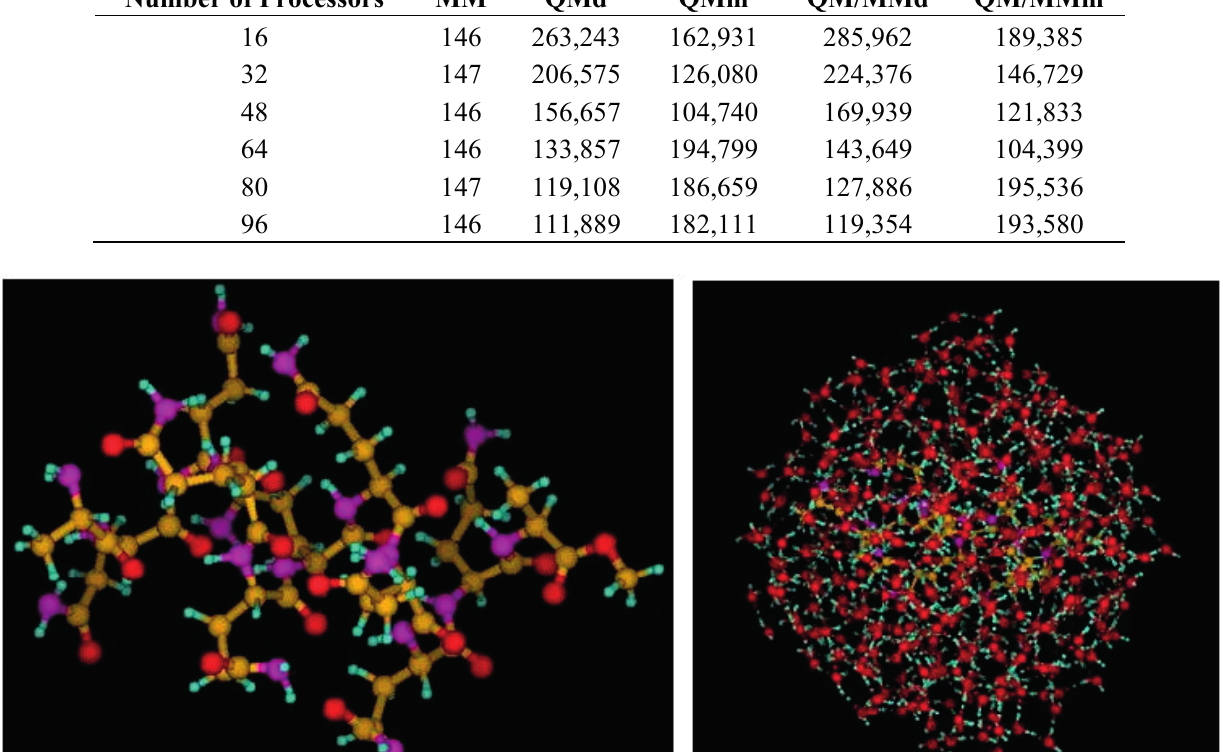
Table 2. Molecular dynamics timings [s] for benchmark calculations of the in-deMon2k QM/MM implementation. See text for details.